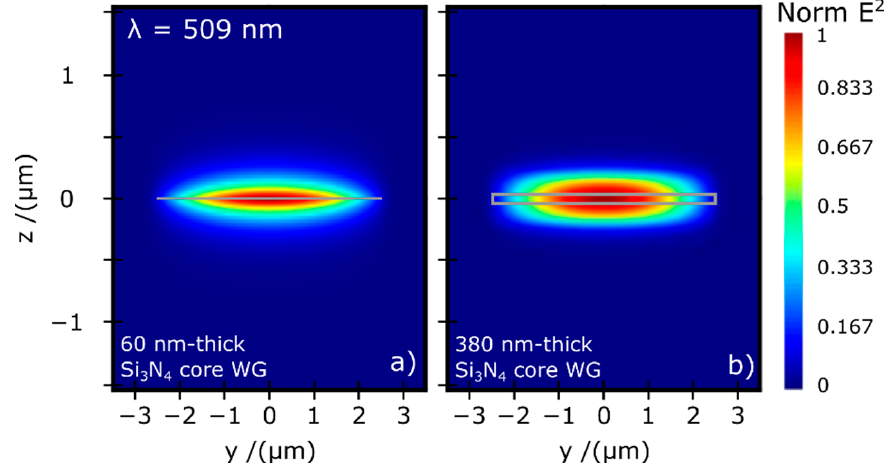
Figure 8. TE 0 mode distributions for waveguides with core of ( a ) 60 nm-thick and ( b ) 380 nm-thick Si 3 N 4 . The light has a wavelength λ = 509 nm.